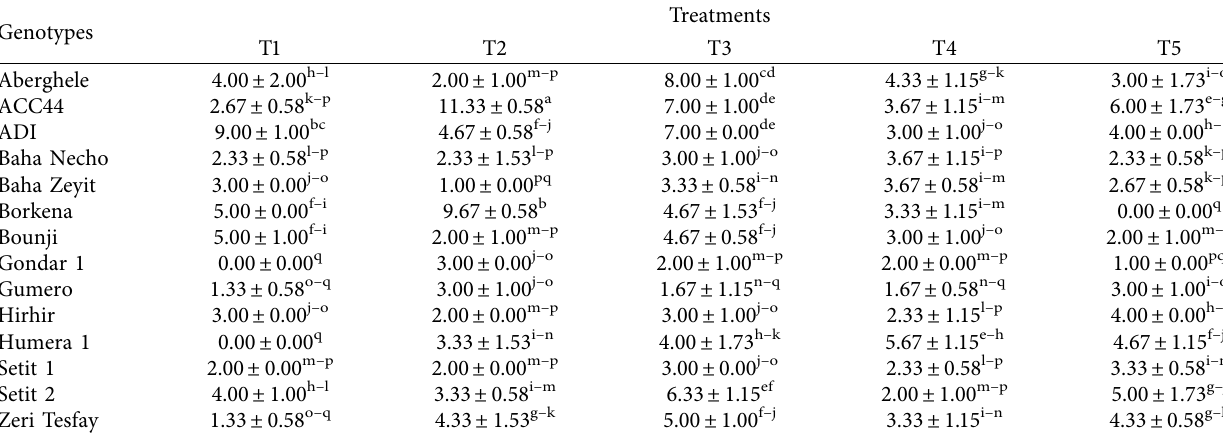
Table 6: Interaction effects of IBA and NAA supplements and genotypes on the mean root length.